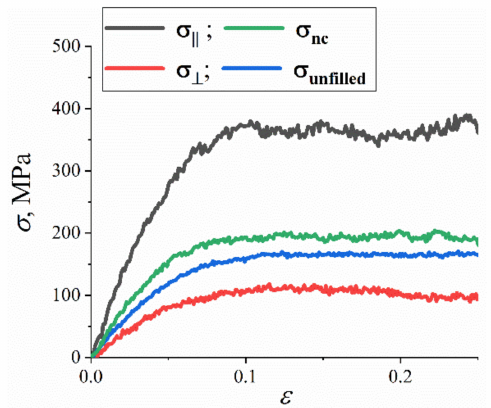
Figure 7. The representative stress-strain dependence for the unfilled amorphous R-BAPB and R-BAPB ordered by SWCNT. The stress-strain dependence σ ⊥ perpendicularly to the SWCNT was calculated as averaged by the X and Y directions, the stress-strain dependence along σ || the SWCNT surface was in Z direction. Additionally, the averaged stress-strain dependence σ nc of nanocompos- ites is shown. The averaging was carried out over three directions of applied deformations. The mechanical properties of amorphous unfilled σ unfilled R-BAPB samples were taken for comparison with our previous study [41]. The results were calculated by computer simulations using Equation (3).